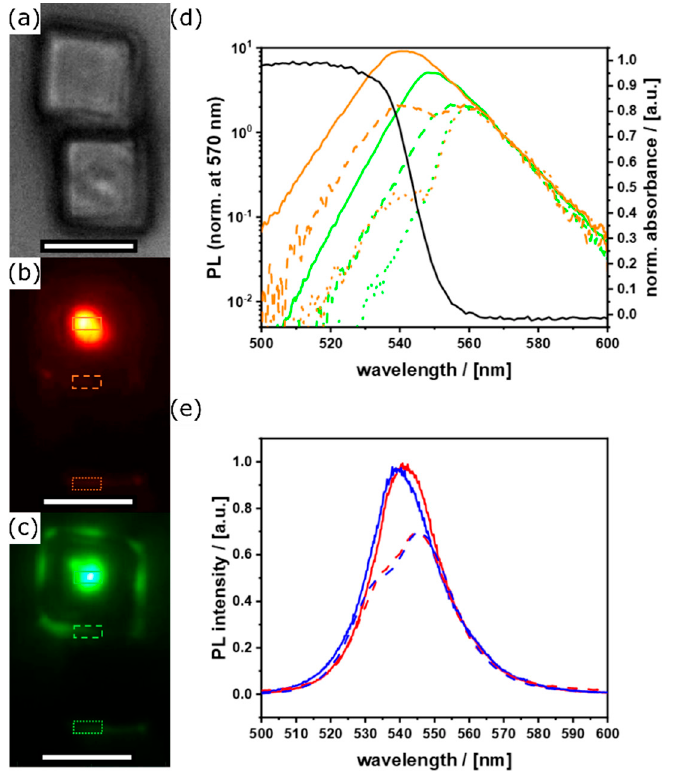
Figure 10. ( a ) Optical brightfield micrograph (scale bars = 10 μ m) of neighboring cubes, false color representations of PL emission generated by ( a ) linear absorption at 400 nm and ( c ) 2PA at 800 nm; ( d ) corresponding emission spectra at the positions as indicated by the colored boxes in ( b ) (orange lines) and ( c ) (green lines), absorbance spectrum of the same sample (black line). ( e ) Comparison of μ PL (solid lines) and ensemble measurements (dashed lines) of RD (blue) and CU (red) particles.